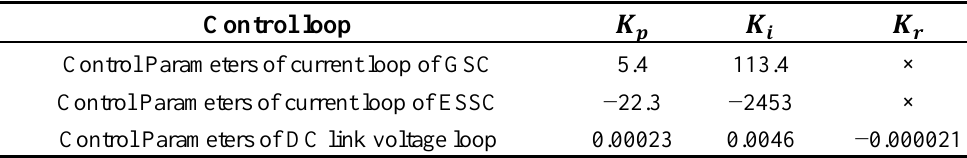
Table 3. Control parameters of